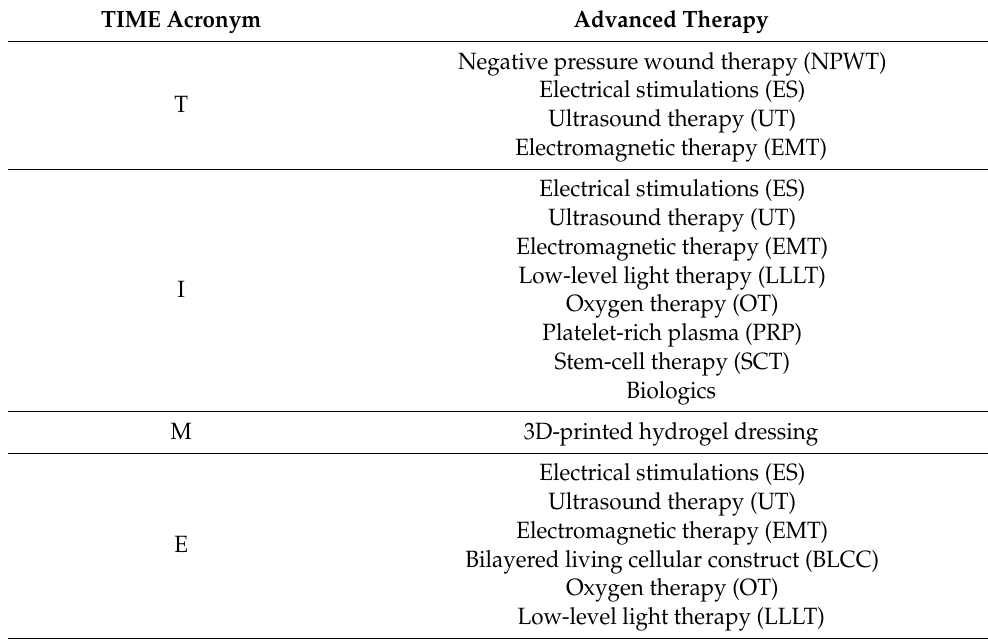
Table 2. The influence of the VLUs advanced therapies/new technologies on the individual aspects of the TIME wound bed